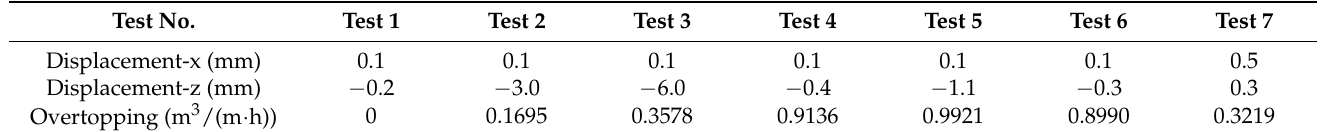
Table 4. Displacement of structure B and overtopping in Test 1 to Test 6.